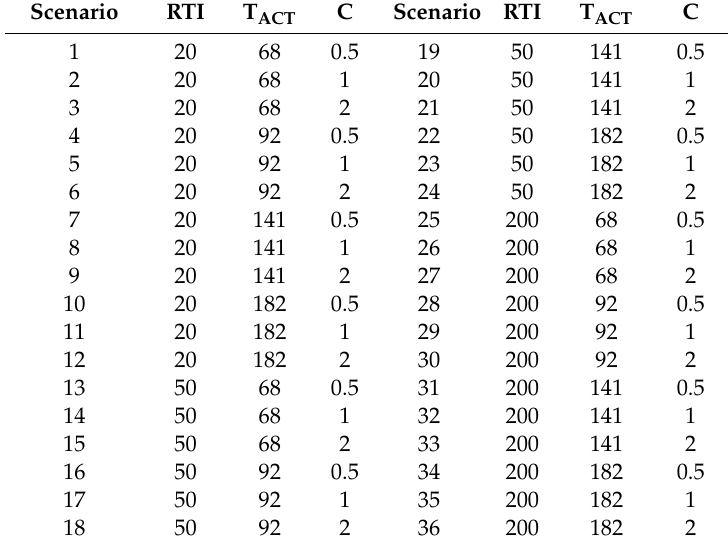
Table 2. The matrix of scenarios and user-defined variables used in this examination.